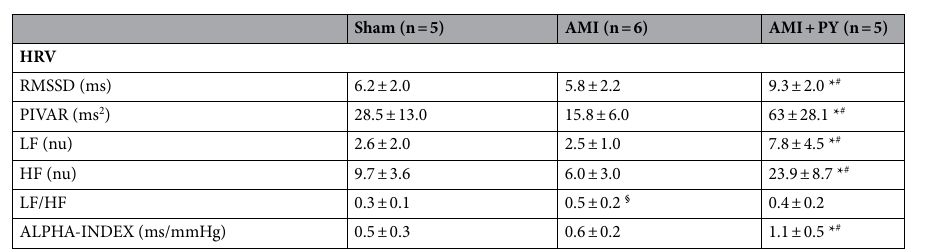
Table 2. Heart rate variability (HRV) and Baroreflex Sensitivity (alpha-index) in all groups. Values expressed as mean ± SEM. § AMI vs Sham; * AMI + PY vs Sham and # AMI + PY vs AMI. HRV: heart rate variability; RMSSD: square root of the mean of the sum of squares of the differences between successive pulse interval values; PIVAR: pulse interval variance; LF: Low Frequency nu: Normalized units; HF nu: high frequency in normalized units; LF/HF: autonomic balance. * P < 0.05; # P < 0.05; § P < 0.05. Statistical significance was determined by one-way ANOVA followed by a multiple comparisons test Tukey’s was performed using GraphPad Prism version 9.0.1. www. graph pad.